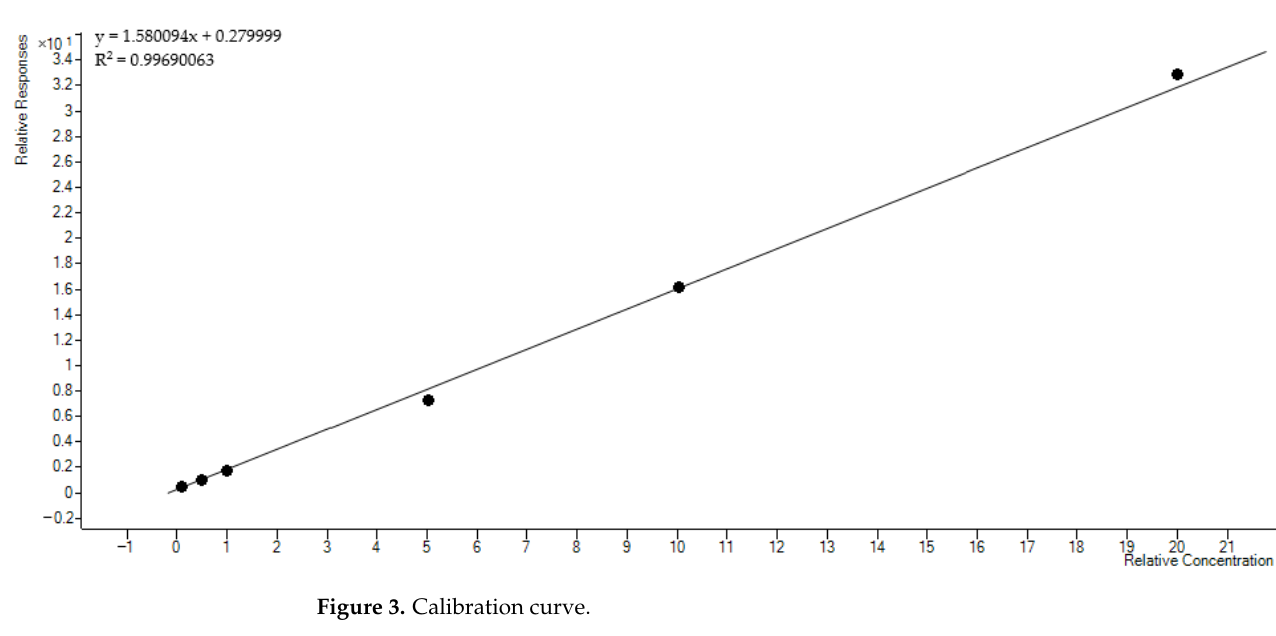
Figure 3. Calibration